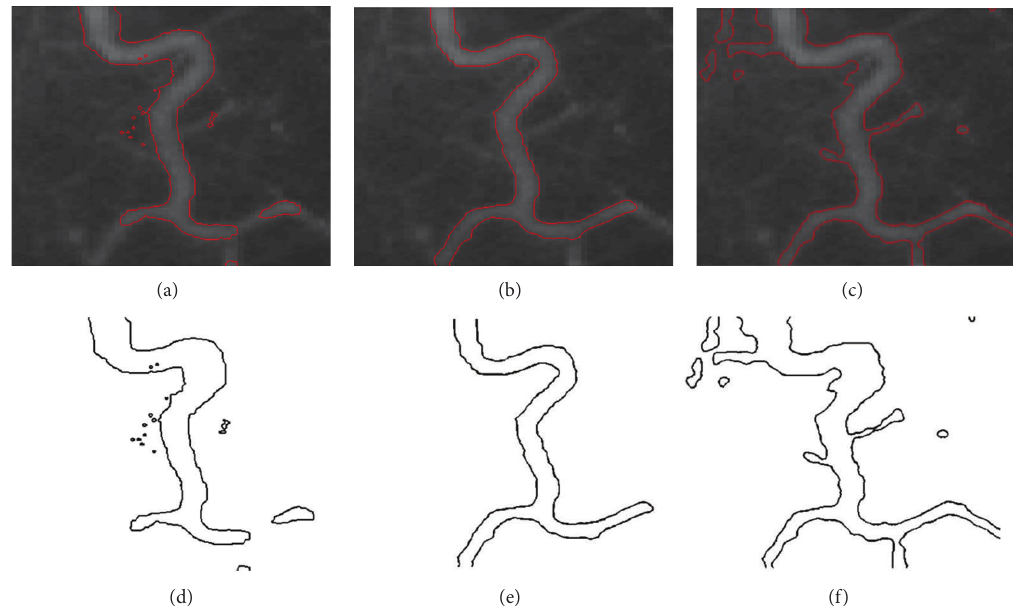
Figure 4: The segmentation results of the blood vessels image: (a) and (d) results using CV model, (b) and (e) results using LBF model, and (c) and (f) results using the new model.